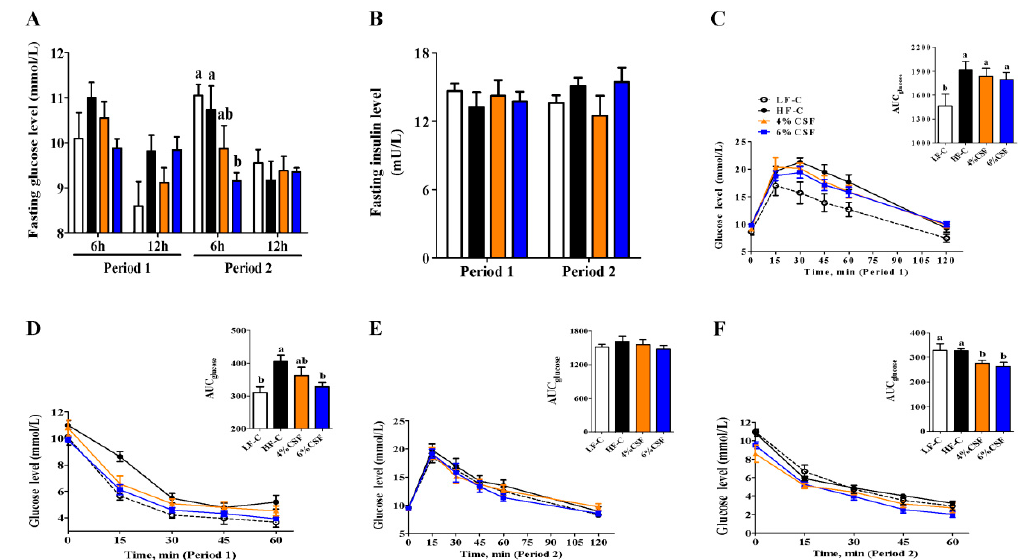
Figure 2. CSF improves insulin sensitivity in DIO Mice. ( A ) 6-and 12-h fasting serum glucose at the end of period 1 and period 2 (n = 6–7). ( B ) Overnight fasting insulin levels at the end of period 1 and period 2 (n = 6). ( C , E ) Intraperitoneal glucose tolerance test (IGTT, 2 g/kg) (n = 6–7) and the area under the curve (AUC) during period 1 ( C ) and period 2 ( E ). ( D , F ) Intraperitoneal insulin tolerance test (IITT, 1 IU/kg) (n = 6–7) and the AUC during period 1 ( D ) and period 2 ( F ). Data are expressed as mean ± SEM. Statistical significance was assessed by Tukey’s test for multiple comparisons. ab means in the same bar without a common letter differ at p < 0.05.